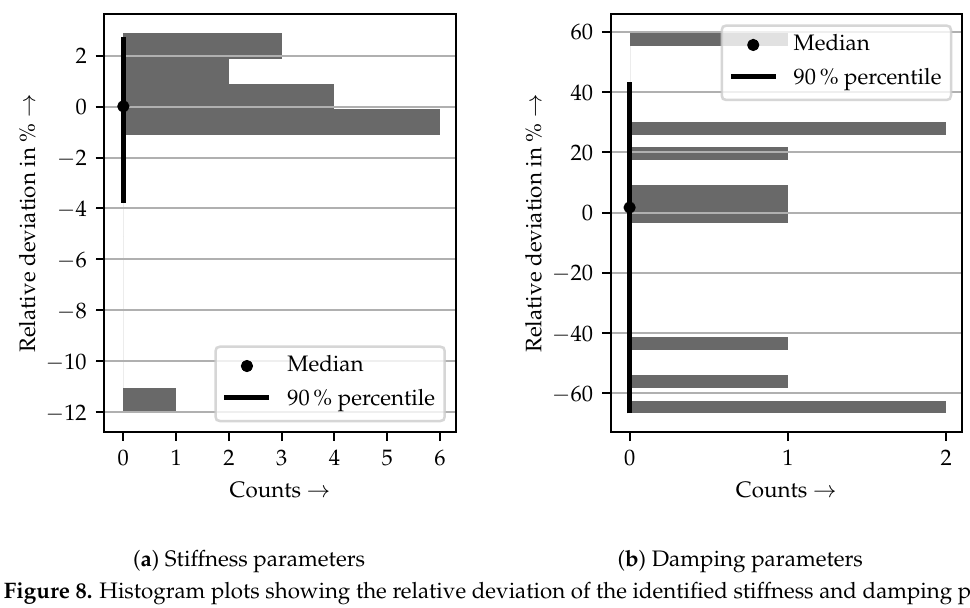
Figure 8. Histogram plots showing the relative deviation of the identified stiffness and damping pa- rameters from their true known value for the case “disturbed model vs. simulated data”; additionally, their median value and 90% percentiles are shown.